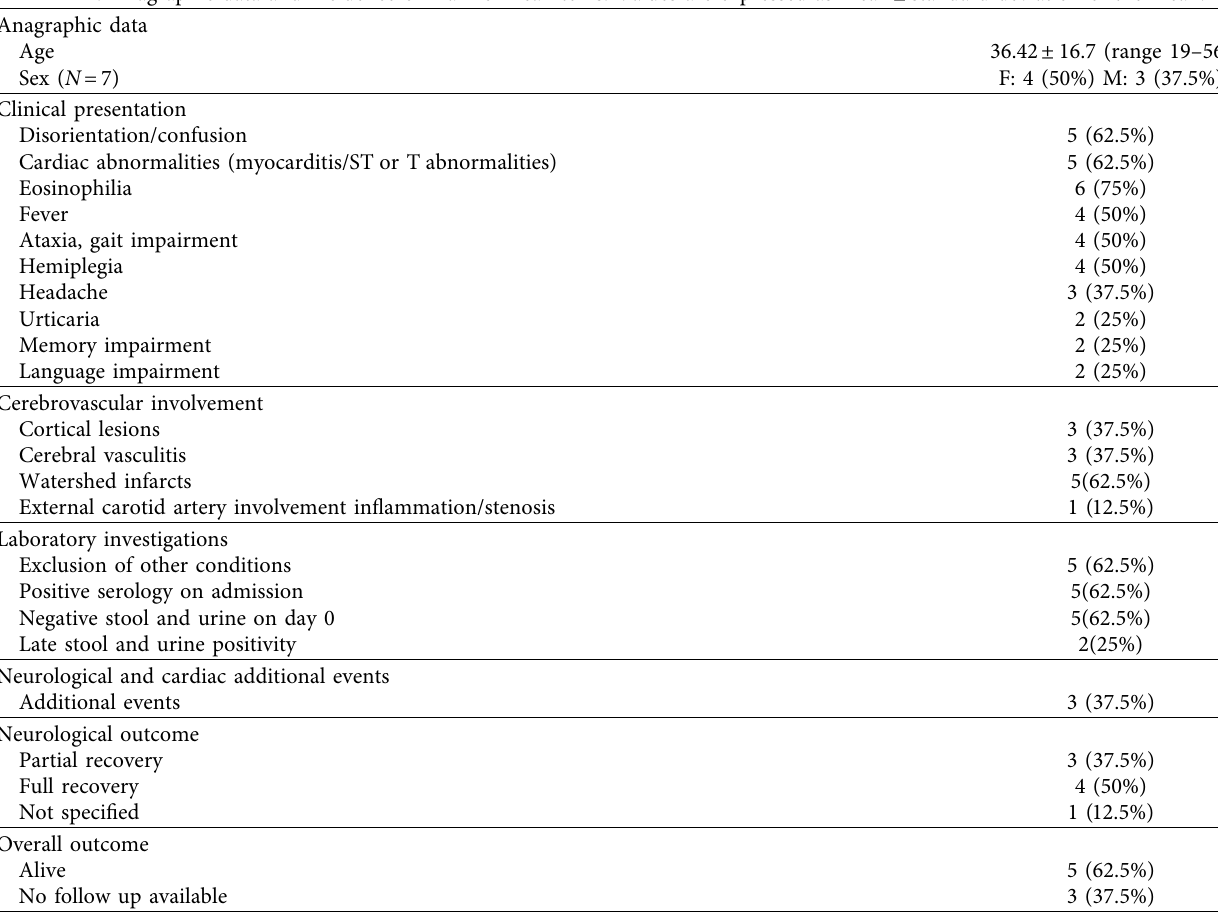
Table 2: Anagraphic data and incidence of main clinical items. Values are expressed as mean ± standard deviation of the mean.